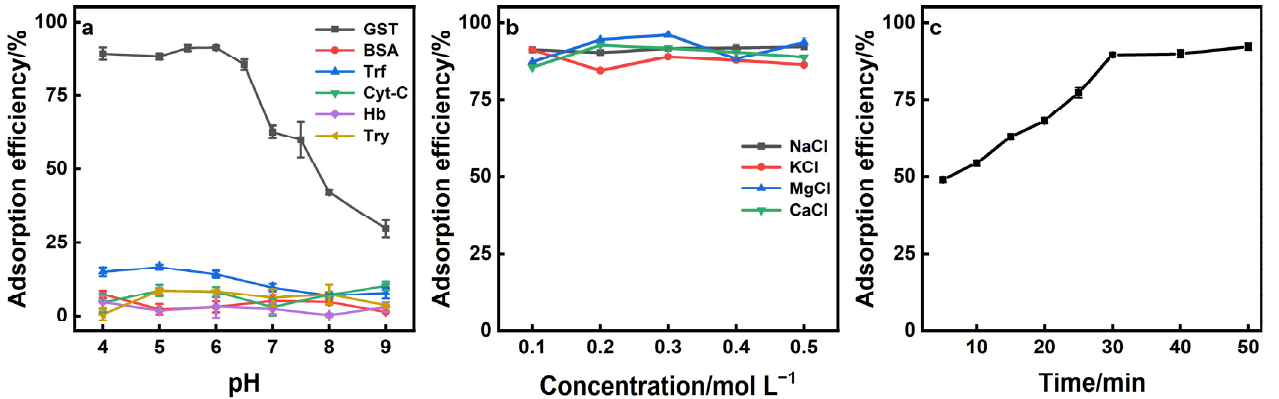
Figure 4. ( a ) Adsorption efficiencies of GST, BSA, Trf, Cyt-C, Hb, and Try onto the GPG composite